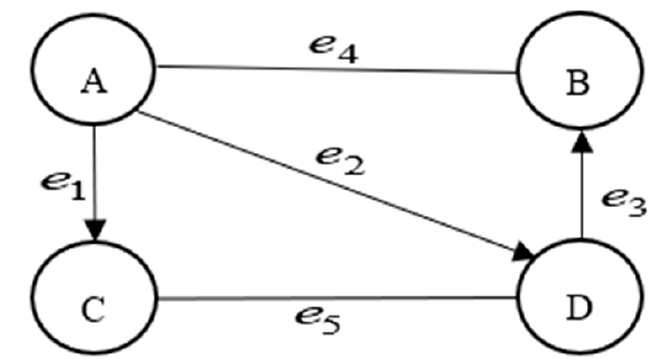
Figure 1. Semidirected graph.